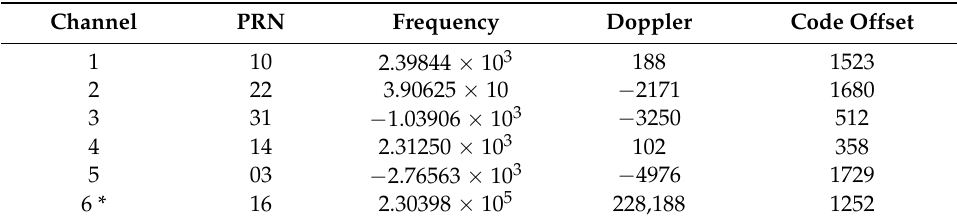
Table 4. PRNs of Dataset